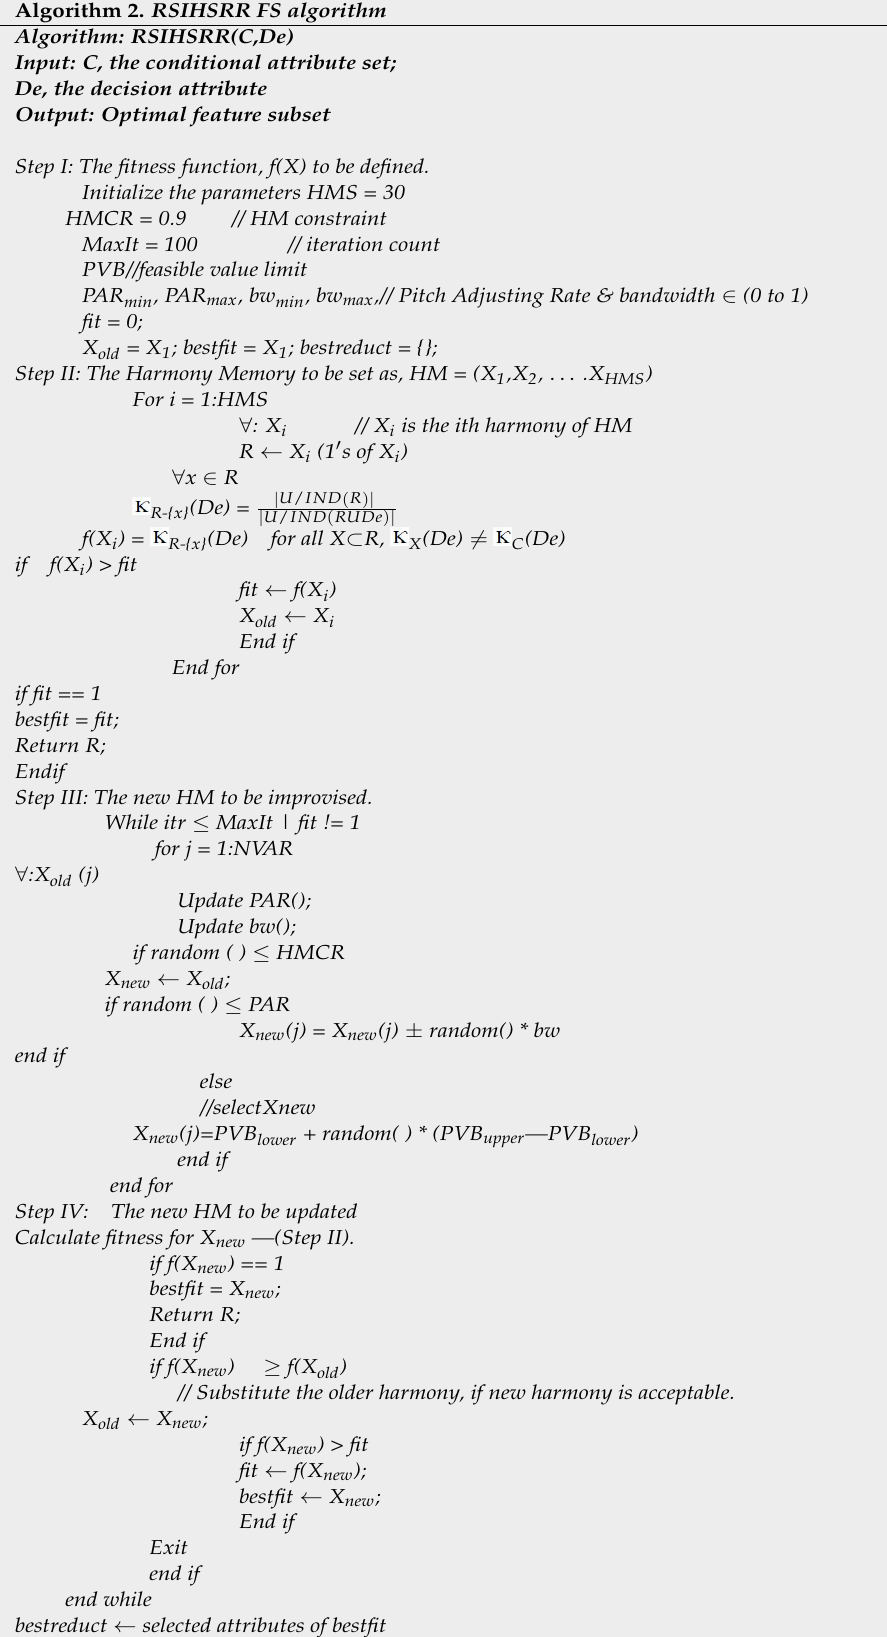
Algorithm 2. RSIHSRR FS